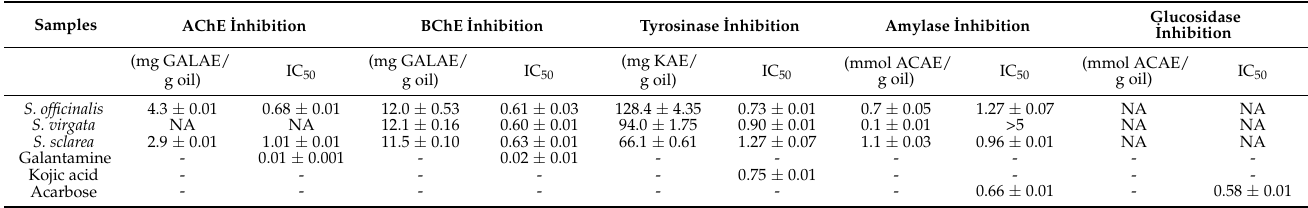
Table 3. Enzyme inhibitory properties of the Salvia essential oils